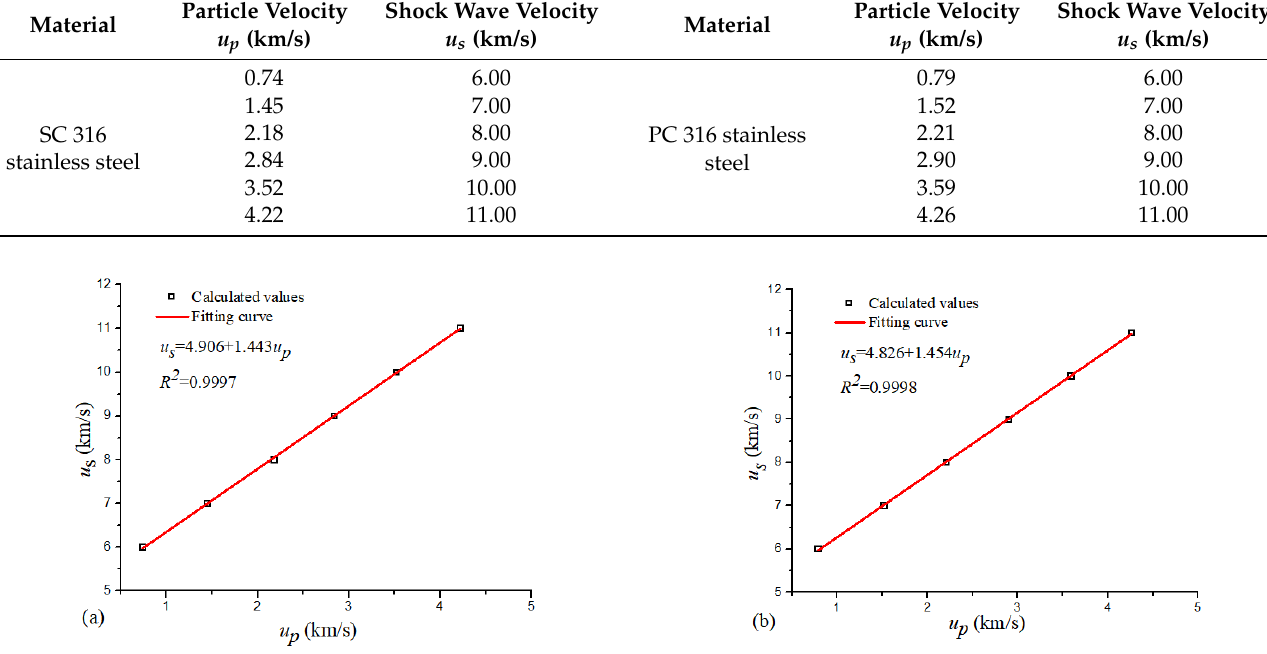
Figure 3. Fitting line of u s vs. u p for 316 stainless steel at 300 K: ( a ) SC model and ( b ) PC model.